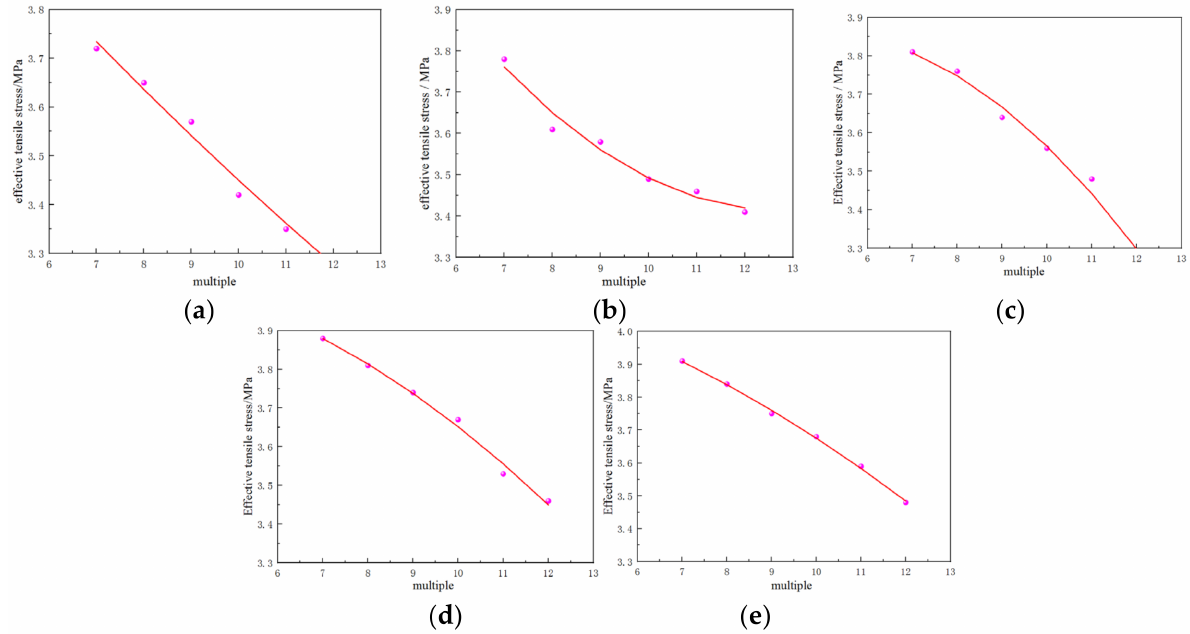
Figure 16. The relation curve between effective tensile stress of different hole diameters and hole spacing. ( a ) 90 mm aperture. ( b ) 100 mm aperture. ( c ) 110 mm aperture. ( d ) 120 mm aperture. ( e ) 130 mm aperture.